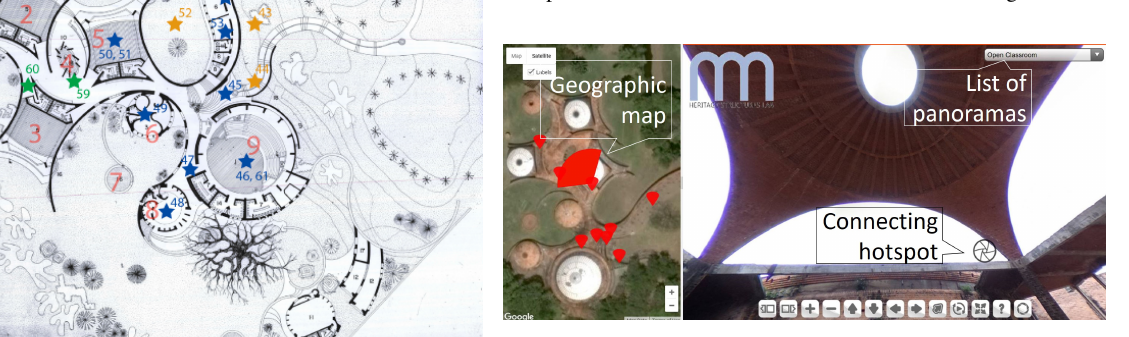
Figure 7. Navigational interface for VT/IM